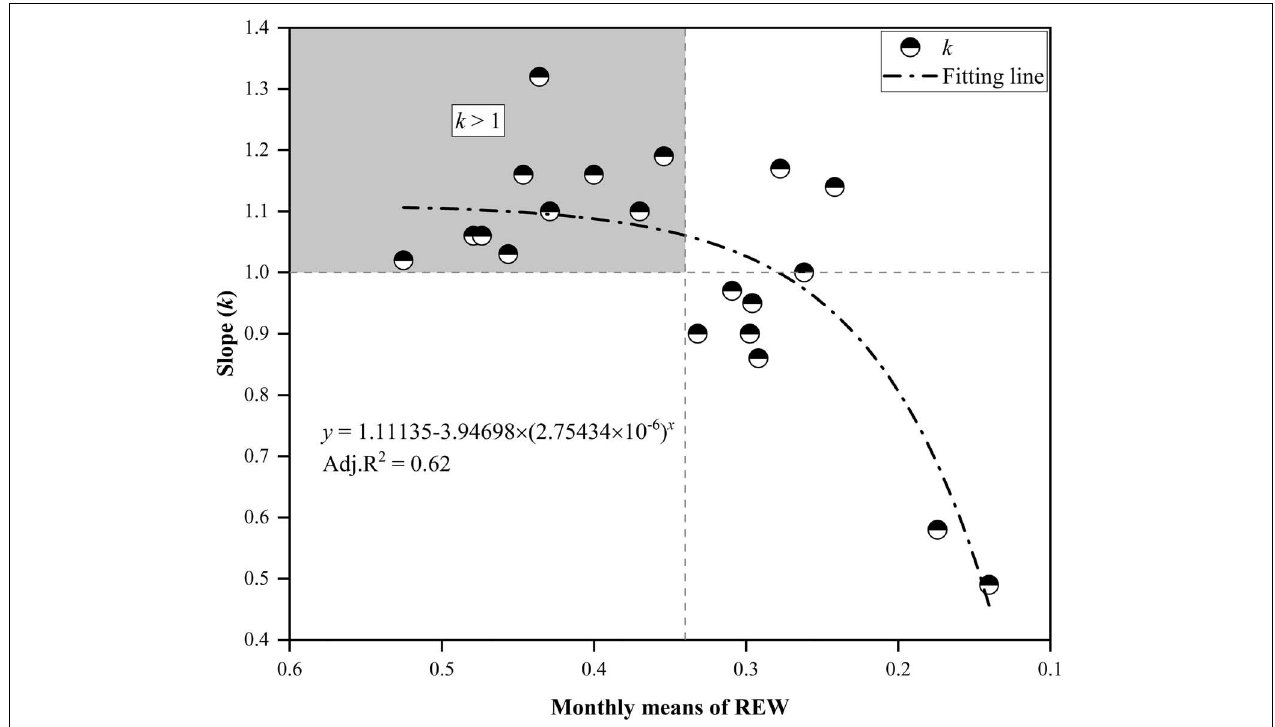
FIGURE 7 | The slope k decreased exponentially with the decline in relative extractable soil water (REW). The upper-left block indicates that the canopy transpiration of Chinese pine ( CP ) was generally higher than that of Mongolian Scots pine ( MP ) when REW was higher than approximately 0.34. The canopy transpiration of CP was below that of MP when REW fell below approximately